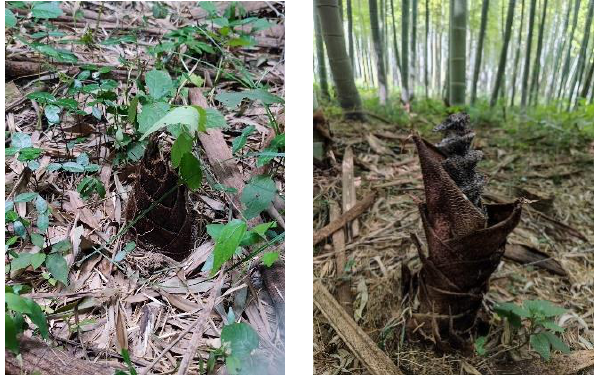
Figure 1. Phenomenon of degraded bamboo shoots in a bamboo forest.